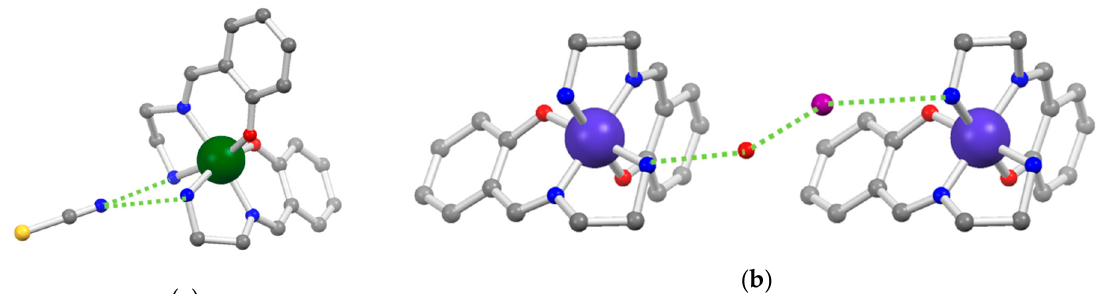
Figure 7. Molecular structures of ( a ) [Fe( H L) 2 ](NCS), CSD/CCDC KETVEL/603305 [109], and ( b ) [Co( H L) 2 ](I) · H 2 O (dimer), CSD/CCDC COSALI/1129940 [117], (L – from H-salH and en in both cases, hydrogen bonds in dashed green lines). Reproduction of the structures with Mercury ® 4.3.1 software [71], color code: I = purple, Co = dark violet, Fe = dark green, S = yellow, O = red, N = blue, C = gray, H omitted for clarity.